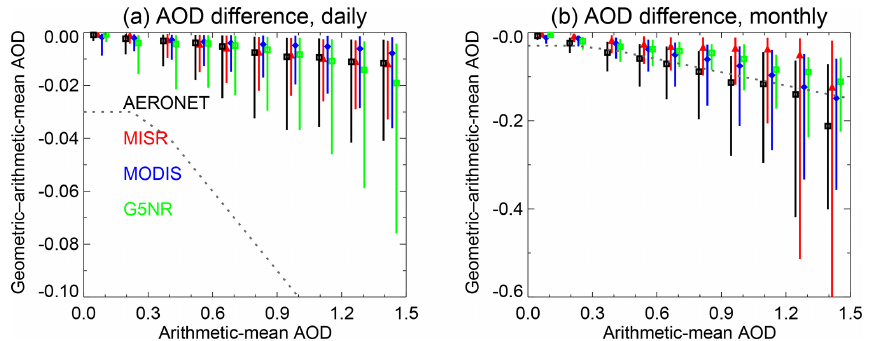
Figure 9. Median (symbols) and central 68% (lines) of binned difference between geometric- and arithmetic-mean AOD ( ¯ τ l − ¯ τ n ) on daily (a) and monthly (b) timescales. Colours indicate AERONET (black), MISR (red), MODIS (blue), or G5NR (green) data. The AOD bin size is 0.15; data sets are horizontally offset slightly for clarity. The dashed grey lines indicate the GCOS goal AOD uncertainty of the maximum of 0.03 or 10%. Table 3. Decadal trends ( ± 1 σ uncertainty estimates) in AERONET AOD at 550nm, estimated using arithmetic- and geometric-mean AOD as a basis for time series. From mean AOD From geometric-mean